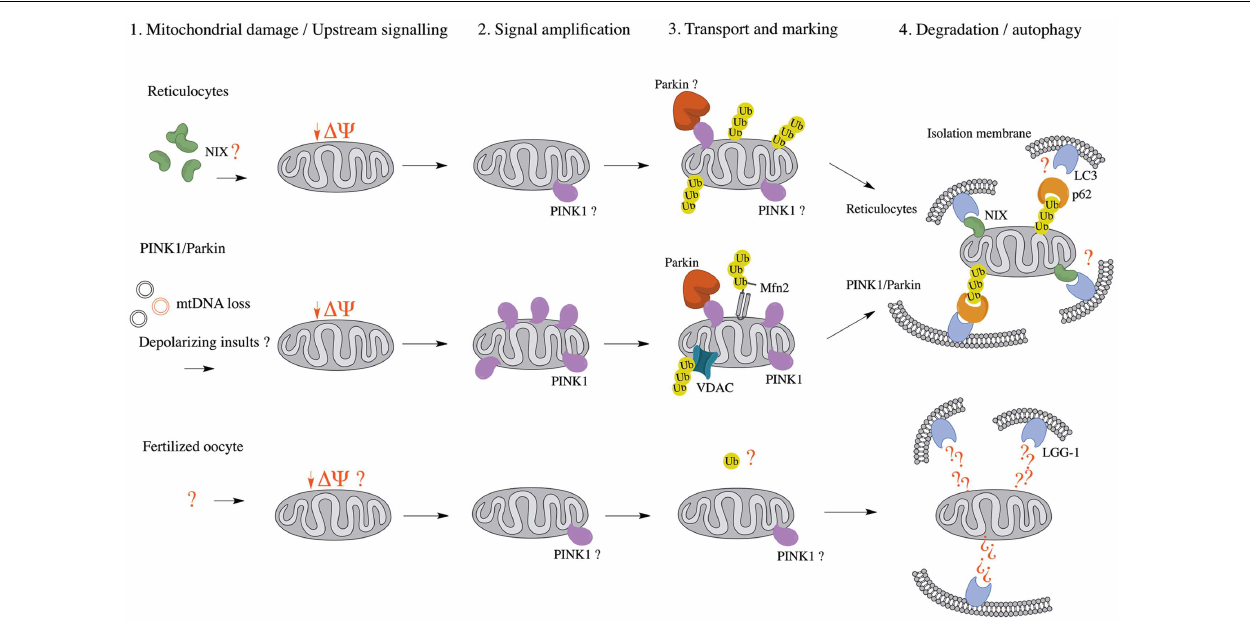
FIGURE 1 | Comparison of known mitophagy pathways (Reticulocytes, PINK1/Parkin, and Fertilized oocyte) in four major steps . (1) Upstream signaling or mitochondrial damage activates mitophagy pathways. (2)The initial mitochondrial signaling or mitochondrial damage converges at a flagship protein, which amplifies the signal. (3) Mitochondria are transported to isolation membrane-rich sites and marked for either proteasomal or